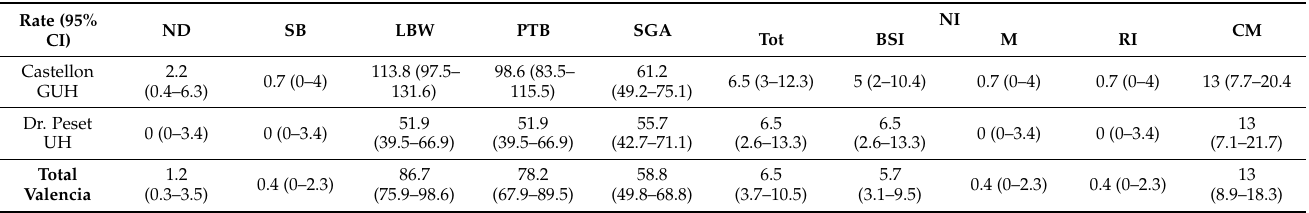
Table 3. Incidence rates (per 1000 live births) for the different perinatal and neonatal outcomes identified, per study site and in